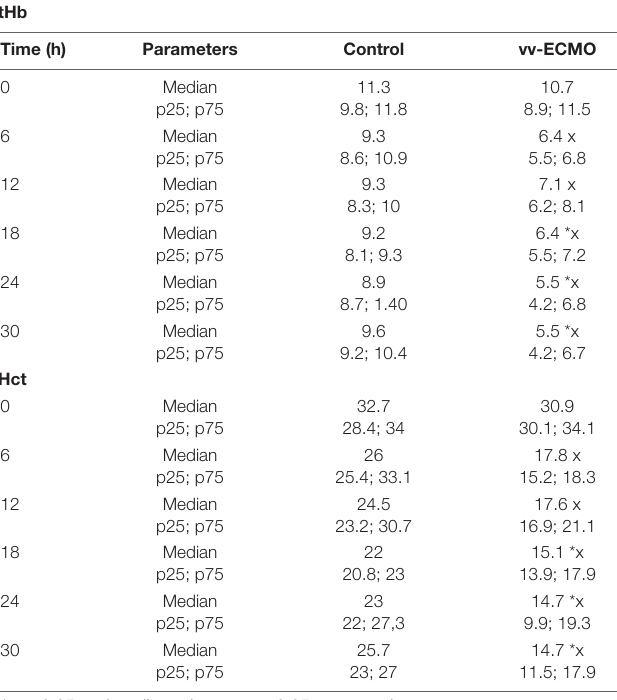
TABLE 1 | The effects of vv-ECMO on blood total hemoglobin concentration (tHb) [g/dL] and hematocrit (Hct) [%]. The table demonstrates the median values and the 25th and 75th percentiles.